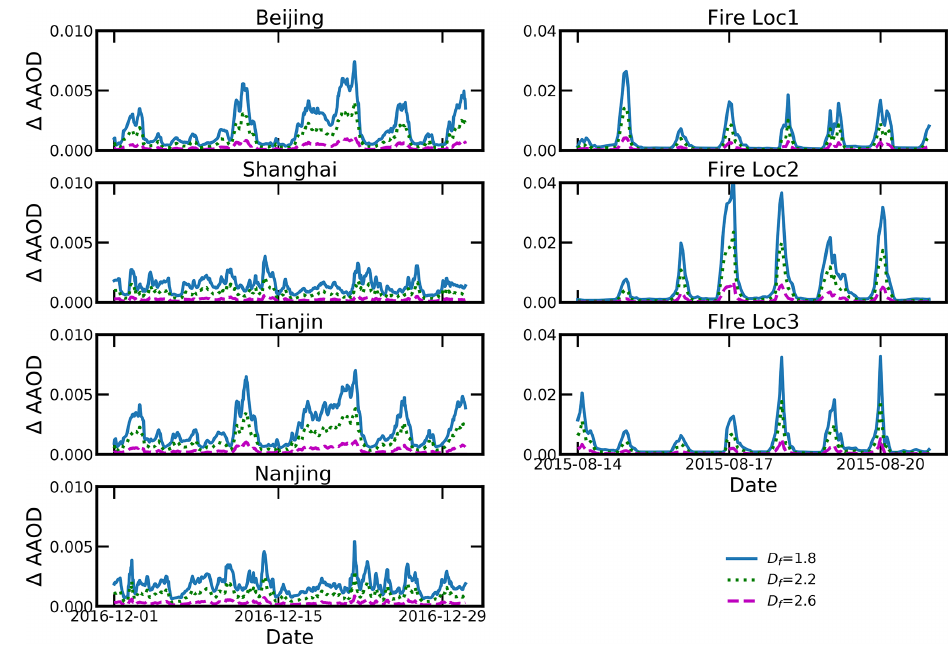
Figure 8. The AAOD difference between fractal aggregate models and the spherical model, λ = 450nm.